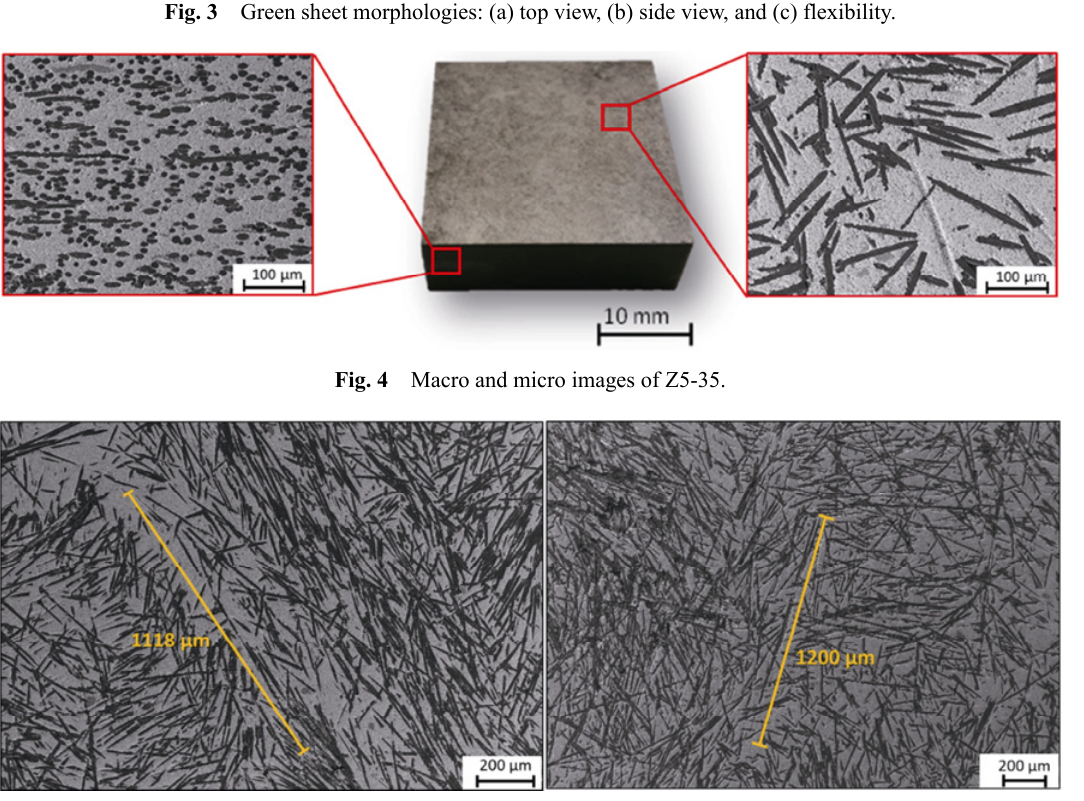
Fig. 5 Top view of fibre length in sample